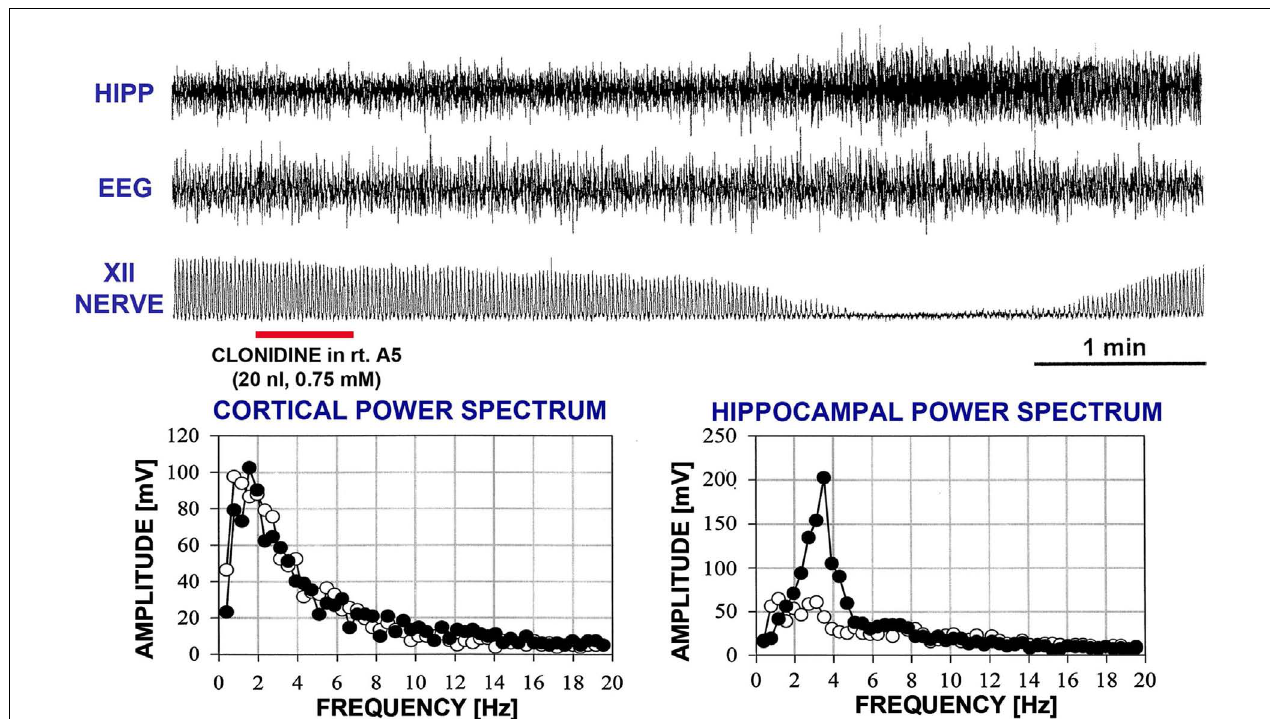
the central respiratory rate was reduced just before the disappearance of XII nerve activity and just after it reappeared when compared with the pre-injection period.The power spectra for the control period and the period centered on the peak of the response are shown with open and filled circles,